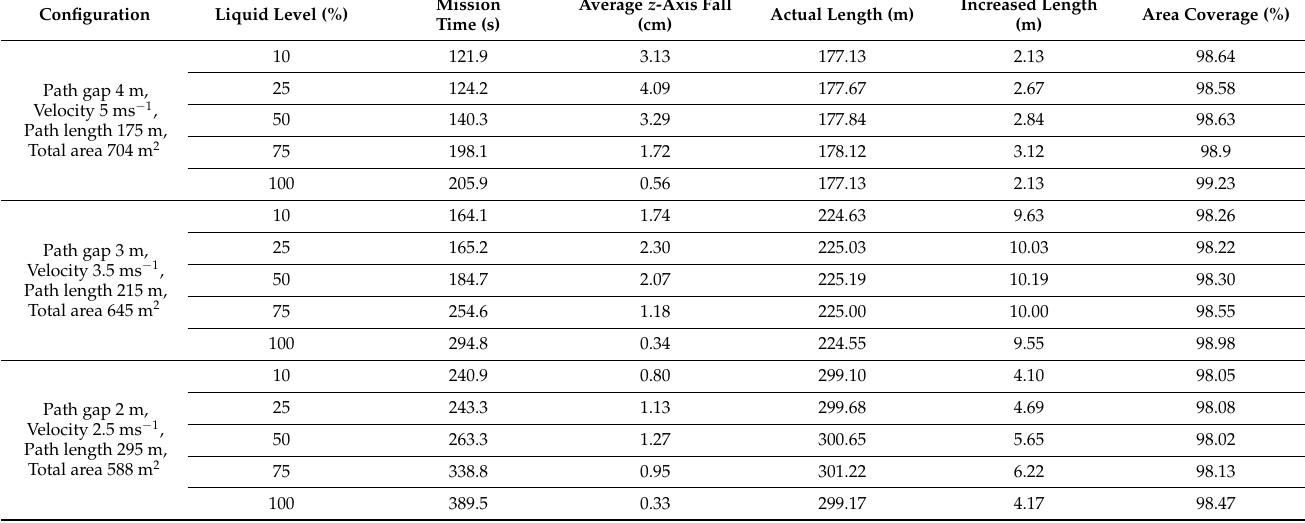
Table 6. Five liquid level mission simulation